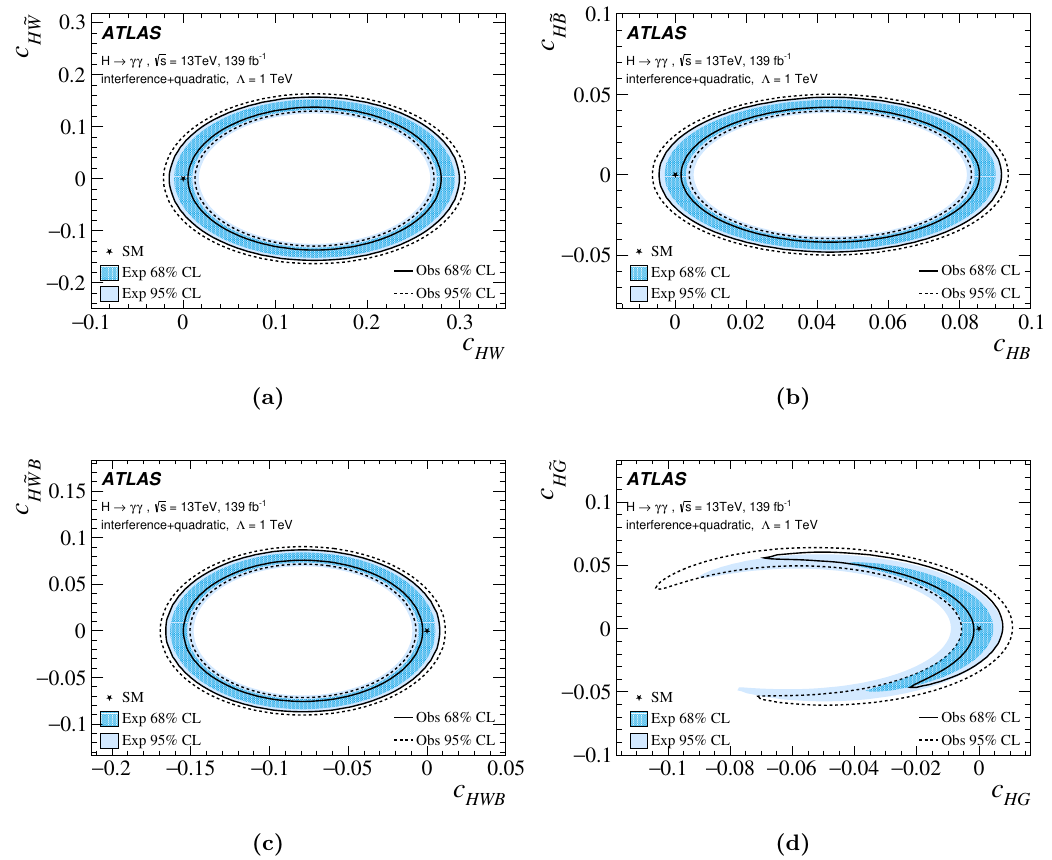
Figure 38. Plots showing the 2D 68% and 95% observed and expected limits obtained from various combinations of two Wilson coefficients including both the SM-dimension-6 interference and the quadratic dimension-6 terms in the SMEFT basis: (a) c , (d) c vs c . The limits are computed at a new-physics scale Λ = 1 TeV . c HG H e WB H e G